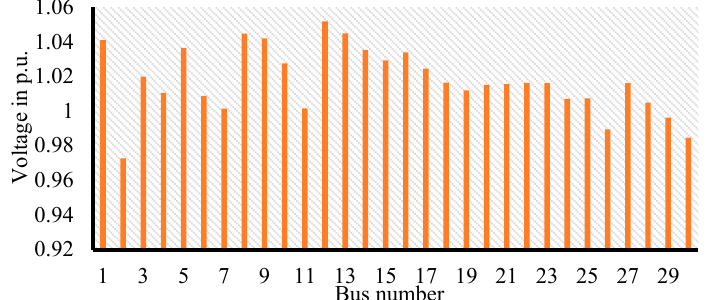
Figure 6. Bus voltage profile for IEEE 30-bus system.